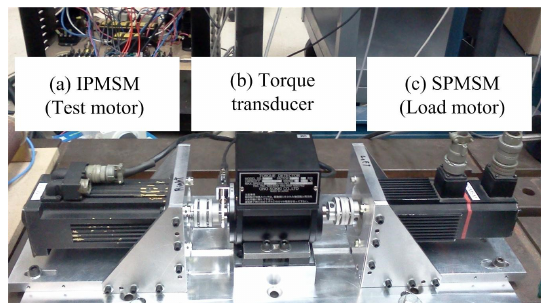
Figure 11. Experimental test set-up. Table 2. IPMSM (interior permanent magnet synchronous motor) specifications.